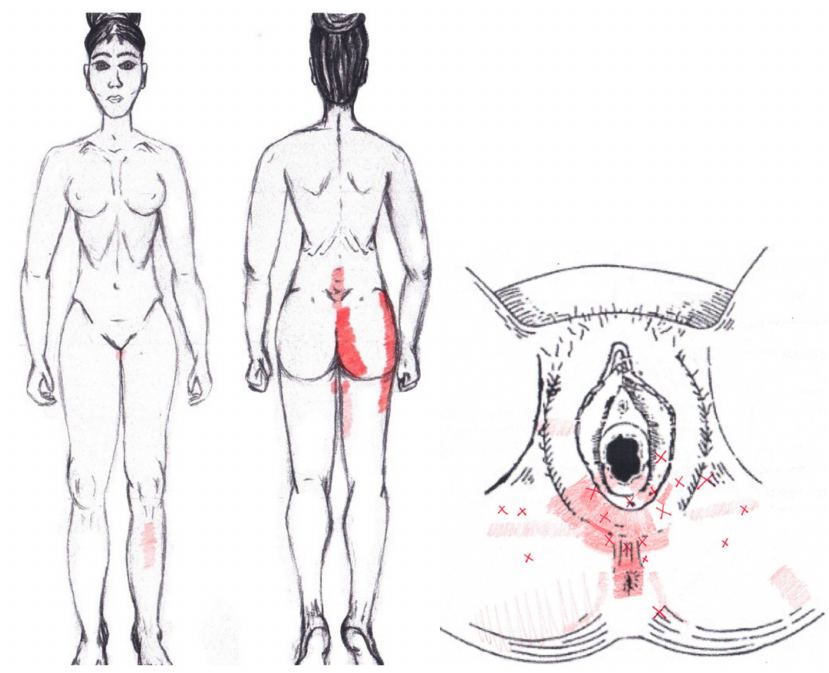
Figure 14. Graphical simulation of referred pain areas of the transverse perineal muscle.